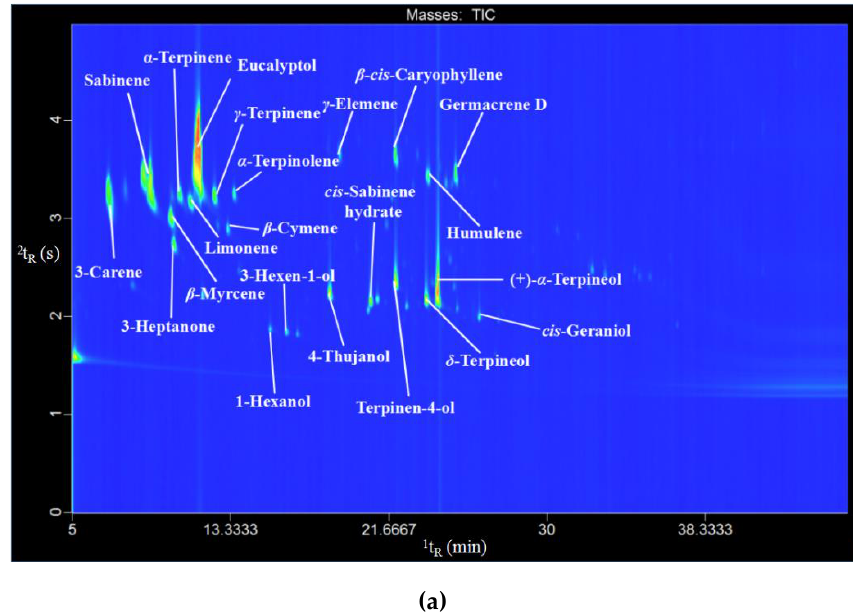
Figure 4. GC×GC total ion chromatogram (TIC) contour plot of two kinds of essential oils from fresh leaf ( a ) and fallen leaf ( b ). 3. Materials and Methods 3.1. Plant and Reagents Fresh and fallen leaves of Cinnamomum camphora were obtained from Sichuan province, China, and the plant was authenticated by Dr. Hong-Yan Liu, Research Center for Plants and Human Health, Institute of Urban Agriculture, Chinese Academy of Agricultural Sciences, Chengdu, Sichuan province, China. The leaves were washed, ventilated, and dried at room temperature (25 °C) for 1 day to dry the blade surface. The dried leaves were ground by a grinder (RS-FS500B, Royalstar Co., Ltd., Hefei, China), and sifted through a 40-mesh sieve (0.425 mm). The